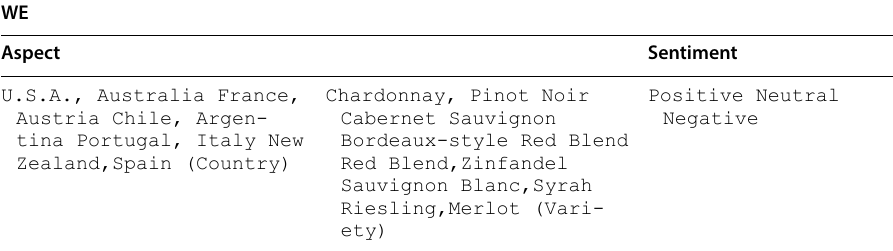
Table 4 Aspects and sentiment of the RT dataset RT Aspect Sentiment Action and Adventure, Animation Art House and Interna- tional Anime and Manga, Classics Comedy, Documentary, Drama Cult Movies, Gay and Lesbian Faith and Spiritual- ity, Horror Kids and Family Musical and Performing Arts Mystery and Suspense